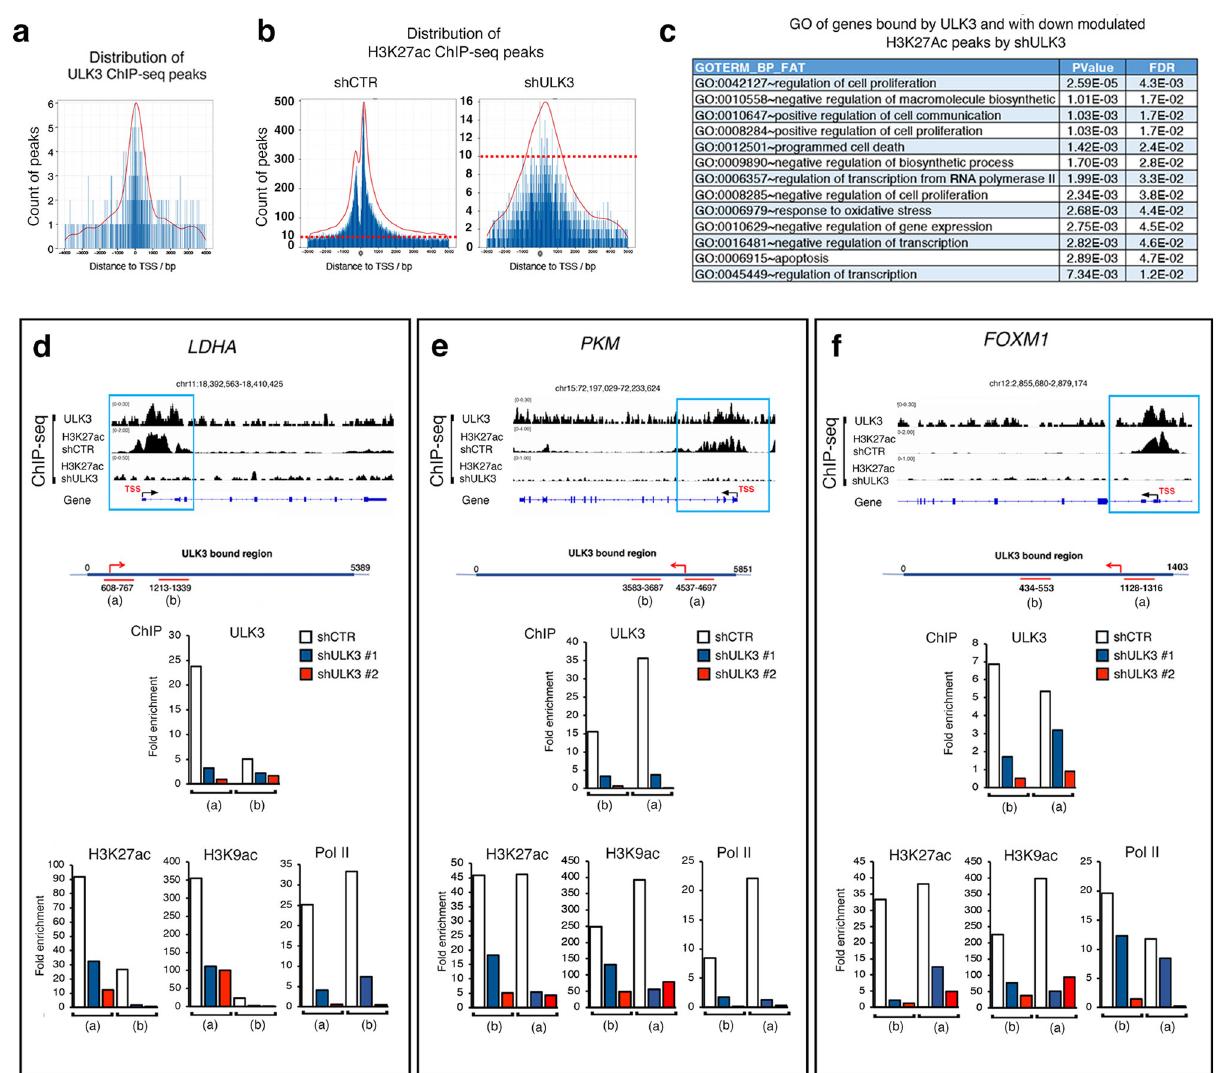
Fig. 5| ULK3 associatesto chromatin regulatory regions ofgenesoffunctional signi fi cance. a ULK3-bound peaks distribution as found by ChIP seq (chromatin immunoprecipitation followed by DNA sequencing) analysis of SCC13 cells with anti-ULK3 antibodies (GSE: 183933). Peaks number (count) per distance (bp) from the Transcriptional Start Site (TSS) of genes. Supplementary Fig. 5a shows the GO using DAVID software of biological processes related to the ULK3-bound genes. b Peaks distribution as found by ChIP-seq analysis with antibodies against acety- lated lysine 27 of histone 3 (H3K27ac) in SCC13 cells plus/minus ULK3 silencing (GSE: 183933). Peaks number (count) per distance (bp) from the Transcriptional Start Site (TSS) of genes. ChIP-seq analysis was made using the Galaxy web plat- form. The magenta dashed lines indicate as a reference between control versus ULK3 silenced(shRNA)cellsthe10-peaksvalue. c GOusingDAVIDsoftwareofmost signi fi cant processes of ULK3-bound genes having downregulated H3K27ac peaks upon ULK3 silencing in SCC13 cells, as determined by ChIP seq analysis (GSE: 183933), P <0.01, Fisher ’ s exact test. Supplementary Fig. 5b shows the Venn